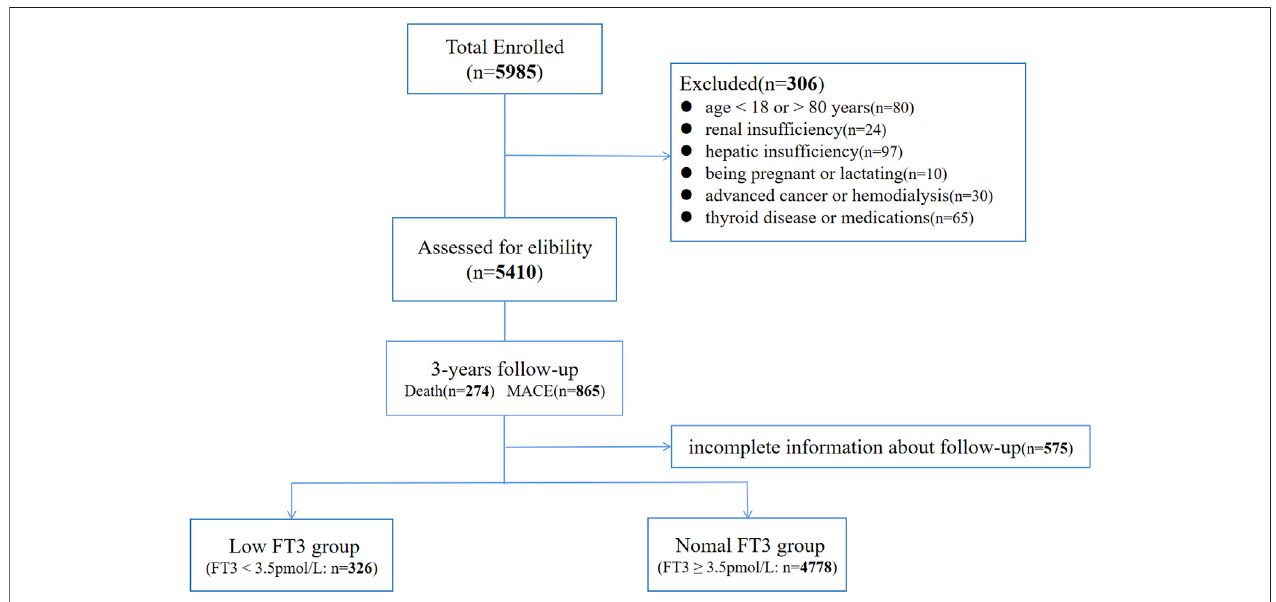
FIGURE 1 | Study design (Flowchart of the study